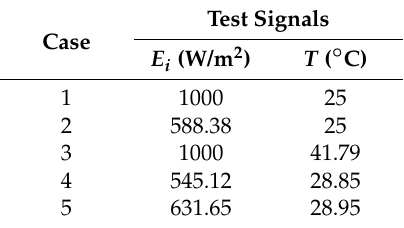
Table 1. Test cases to evaluate the performance of the control algorithms.